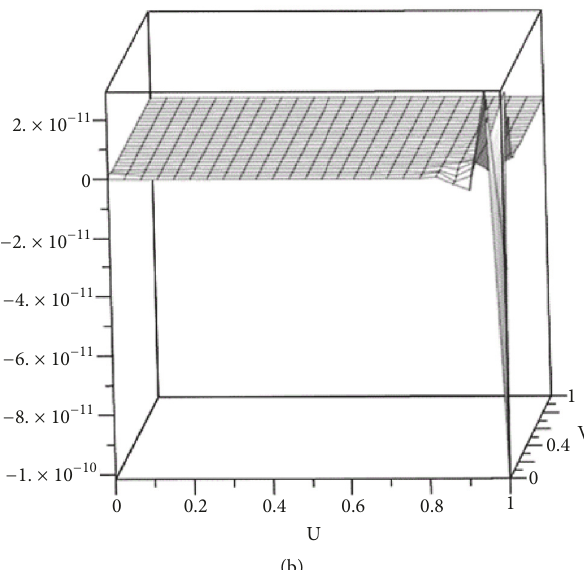
Figure 7: Minimal surfaces built on the basis of a fractional-rational curve. (a) The surface. The reference points are connected by broken bold line. (b) Graph of the function M .